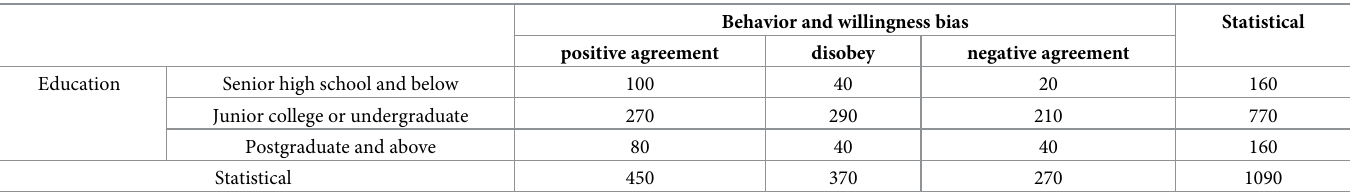
Table 6. Cross analysis of education level and dependent variables.